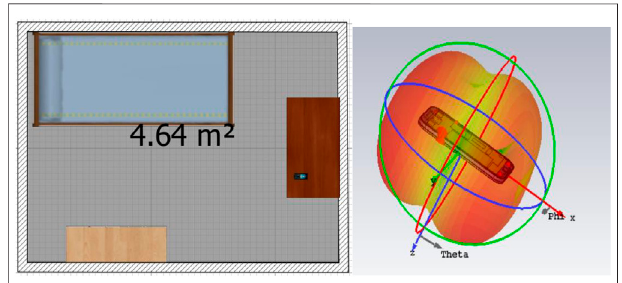
FIGURE6|(A) PlanofrealroomwhereactualEMRmeasurementswere taken (B) Far- fi eld pattern of the smartphone designed in